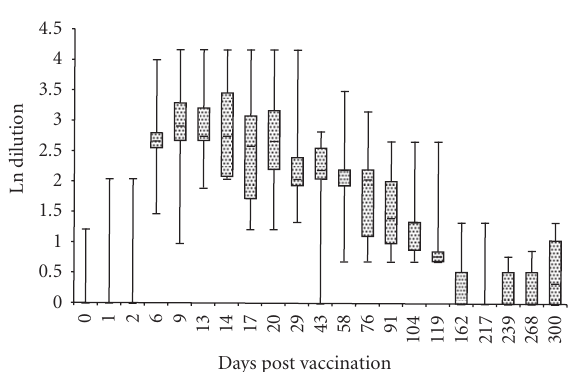
Figure 1: Median, maximum value, minimum value, 25th per- centile, and 75th percentile of RB51-CFT results in vaccinated animals ( n = 10).